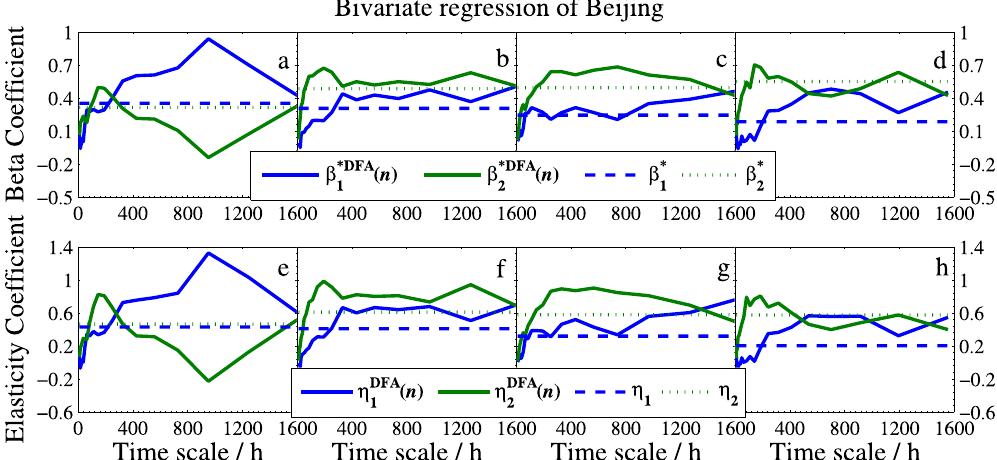
Figure 10. Determination coefficients of bivariate DFA and standard regression model. ( a – d ) Are for models of Beijing, ( e – h ) are for models of Tianjin, and ( i – l ) are for models of Baoding. The solid line denotes R n ( ) the dashed line denotes R 2 .